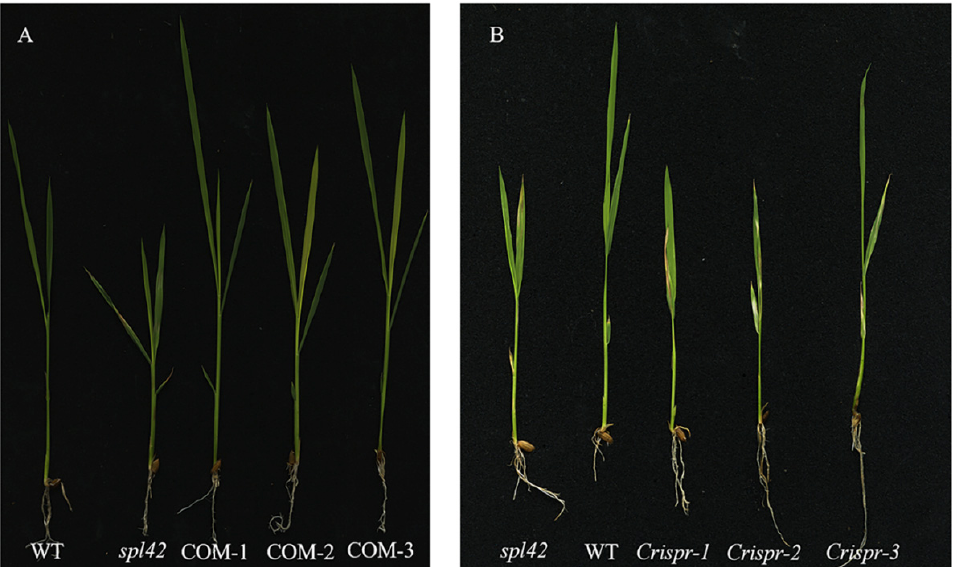
Figure 6. SPL42 complementation and knockout transgene verification. ( A ) Phenotypes of wild type, spl42 mutant, and transgenic complementary plants at the four-leaf stage. ( B ) Phenotypes of spl42 mutant, wild type, and three knockout mutants Crispr-1/2/3.